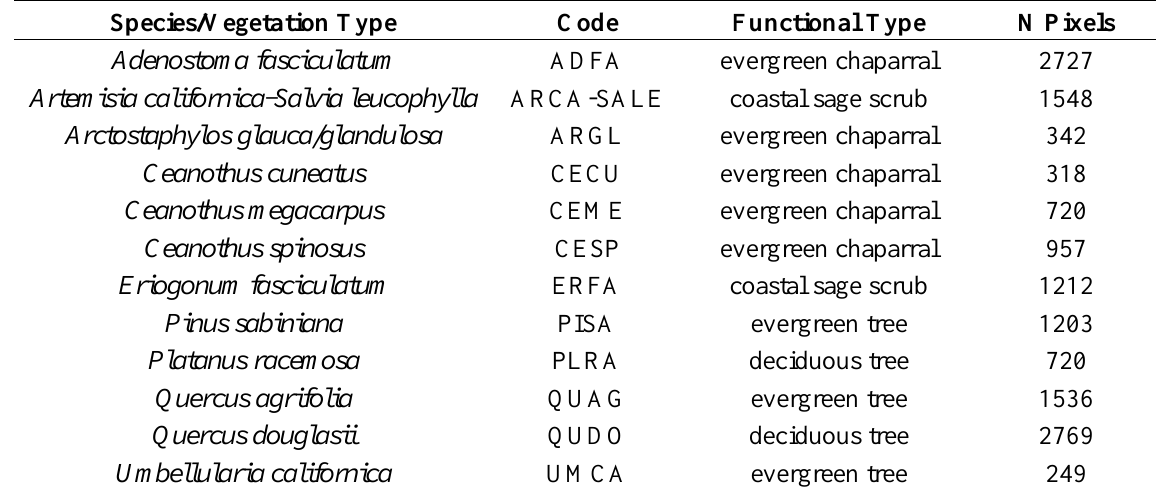
Figure 1. The study region covering the Santa Barbara Coast and portions of the Santa Ynez Mountains and Santa Ynez Valley, California. An AVIRIS images acquired in July 2011 is shown in a 1651 nm (red), 831 nm (green), 658 nm (blue) false color composite. Reference polygons dominated by plant species are marked by yellow dots. Table 1. Species, code, functional type, and number of pixels sampled per